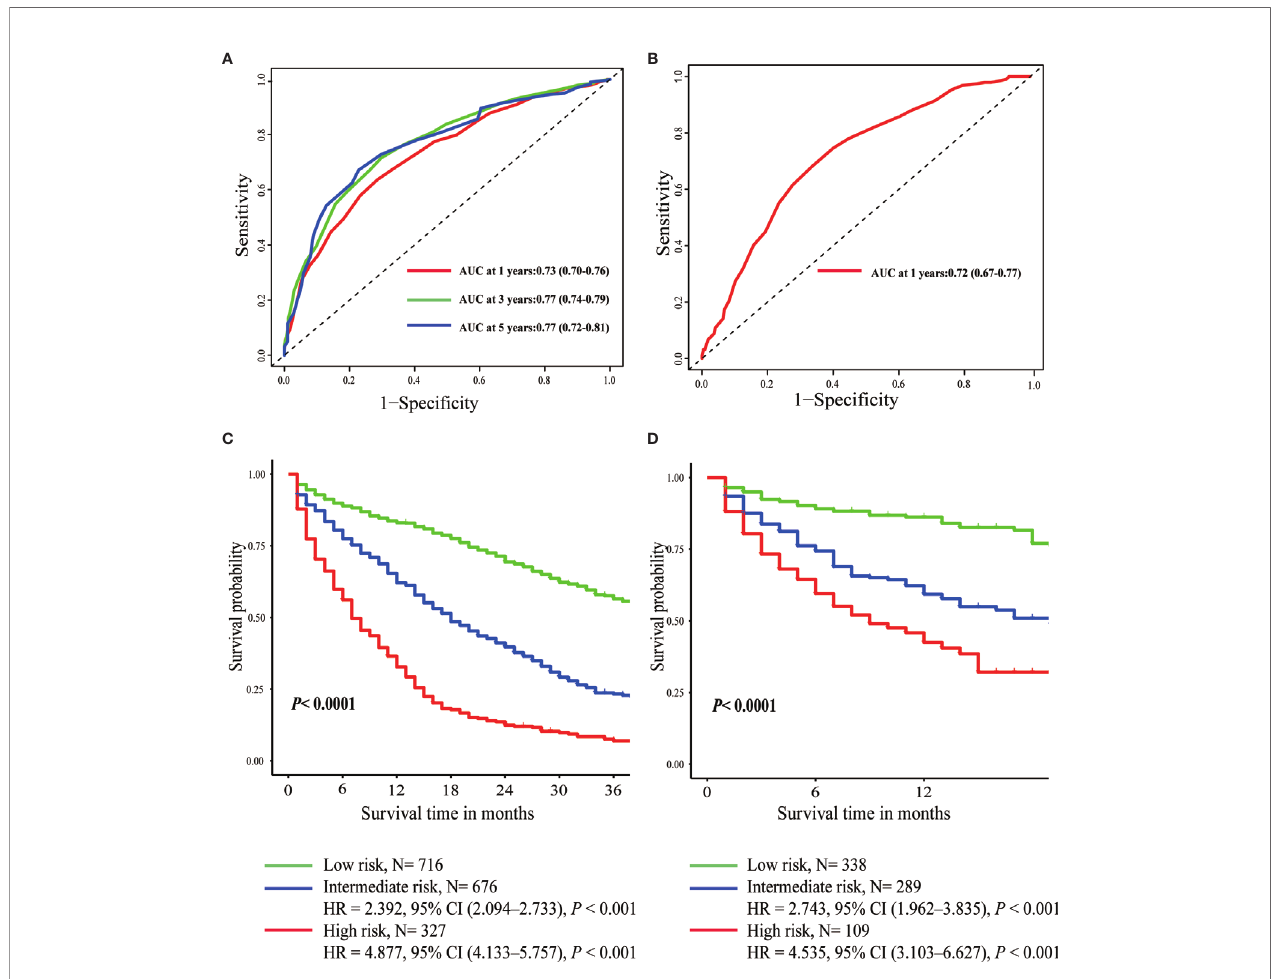
FIGURE 3 | Time-dependent ROC curves of prognostic score in the training set (A) and the validation set (B) . Overall survival curves plotted by Kaplan-Meier method in the training set (C) and the validation set (D) .